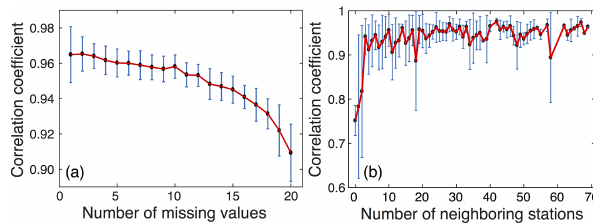
Figure 9. Impacts of the number of missing values present in hourly PM 2 . 5 records for every 24h (a) and the total number of neighbor- ing stations within 100km (b) on the performance of the proposed gap-filling method. The error bars denote 1 standard deviation of each value from the mean on each